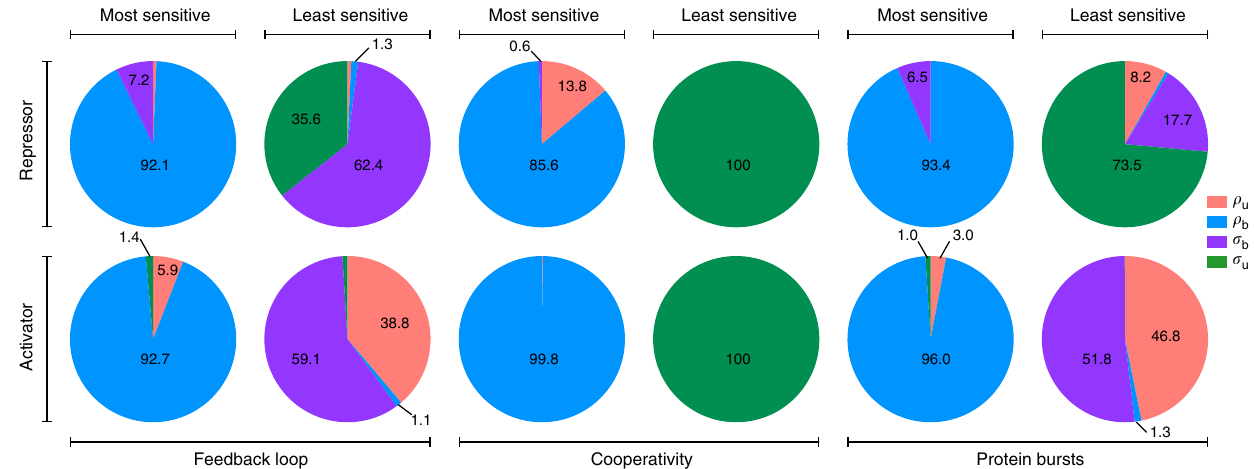
Fig. 8 Sensitivity of the coef fi cient of variation squared to parameter perturbation in steady-state conditions. The pie charts show the most and least sensitive parameters for the three types of non-oscillatory feedback loops, in activating (positive feedback) or repressing mode (negative feedback). Out of the four variables, ρ b is the most sensitive parameter and occupies almost 90% in each of the six cases, whereas the least sensitive parameter is typically either σ b or σ u . The activator stands for ρ b > ρ u , whereas the repressor means ρ u > ρ b . The sensitivity results are obtained by using the LMA to calculate the logarithmic sensitivity of the coef fi cient of variation squared to the four parameters ( σ b , σ u , ρ b and ρ u ) on a regular lattice over the space: ρ b , ρ u ∈ [1, 10 2 ] and σ b , σ u ∈ [10 − 2 , 1]. The lattice spacing is 5 for ρ b , ρ u and 0.05 for σ b , σ u . The cooperativity order was cp = 2 for the feedback loop with cooperativity and the mean protein bursts size was b = 2 for the feedback loop with